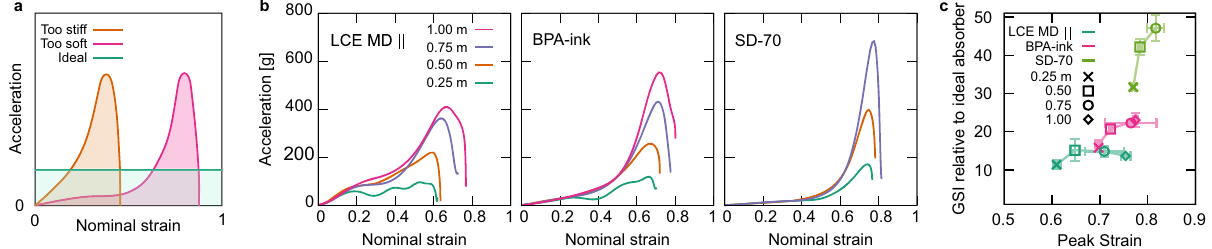
Fig. 4 Impact performance. a Illustration of drop test responses for typical non-porous materials of different stiffnesses, and that of the idealized impact absorber which would fully compress at a constant acceleration. b Representative readings from an accelerometer mounted on a 2 kg mass as it is dropped from various heights onto devices of LCE MD k , BPA elastomer and SD-70. c A summary of drop test results in an Ashby-style plot. Plotting, for each material and drop height, the peak strain against the Gadd severity index (Eq. 3) reveals each material ’ s balance of minimizing the severity of impacts and their capability to increase their maximum strain in response to impacts of greater intensity. Errors represent the